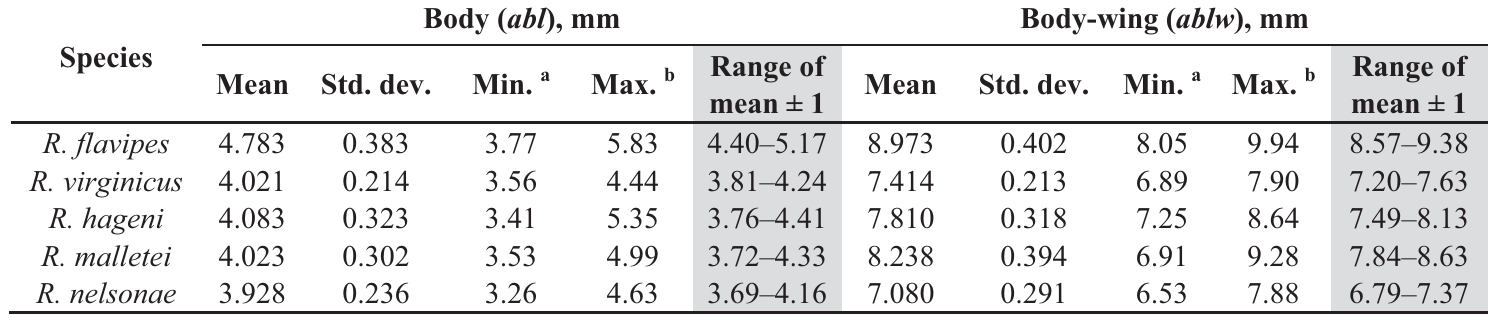
Table 4b. List of alate characters measured by species showing mean, standard deviation, range of values and range of mean ± one std. dev.